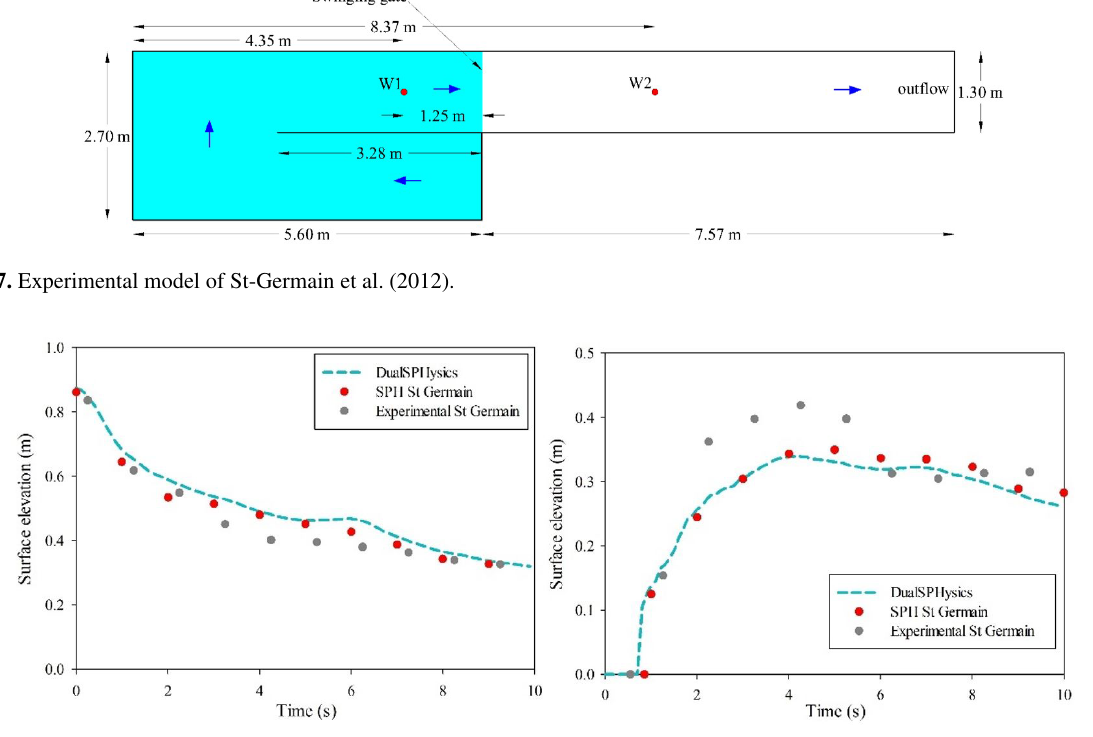
Figure 28. Water heights at points W1 and W2 (St-Germain et al., 2012).